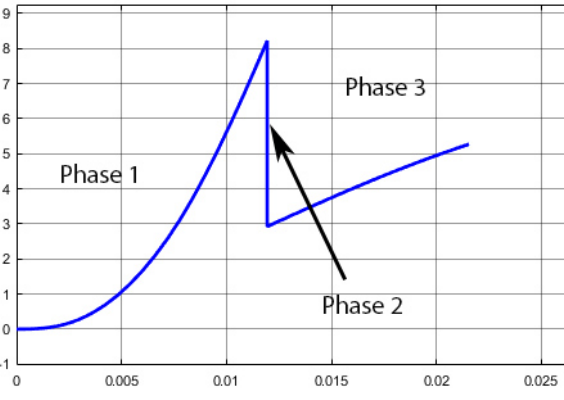
Figure 11. Plunger speed in m . s − 1 over the time in s